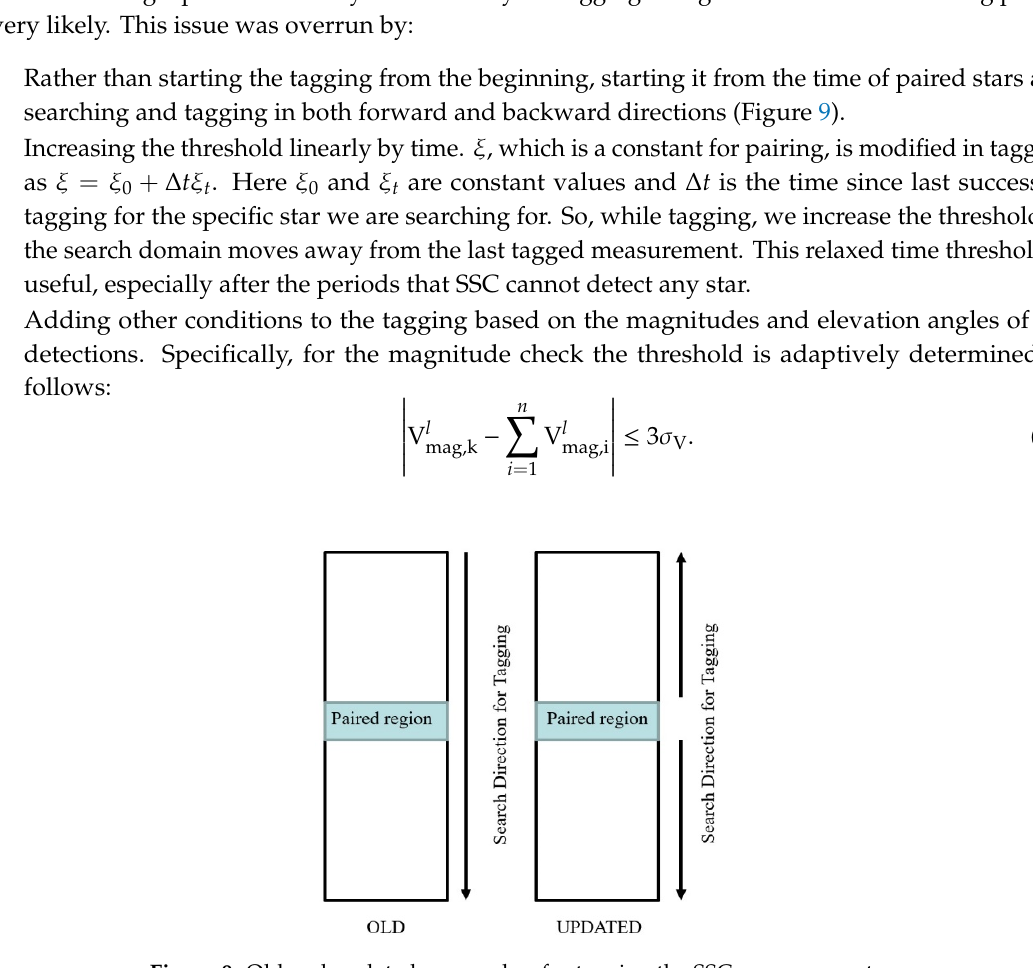
Figure 9. Old and updated approaches for tagging the SSC measurements.